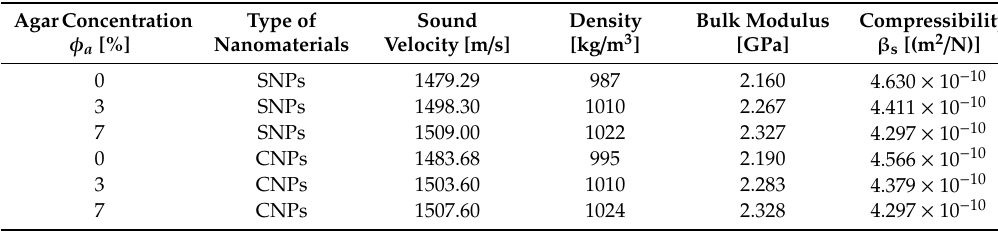
Table 1. Sound velocity, density, bulk modulus and compressibility of agar phantom doped with SNPs / CNPs with di ff erent φ a agar